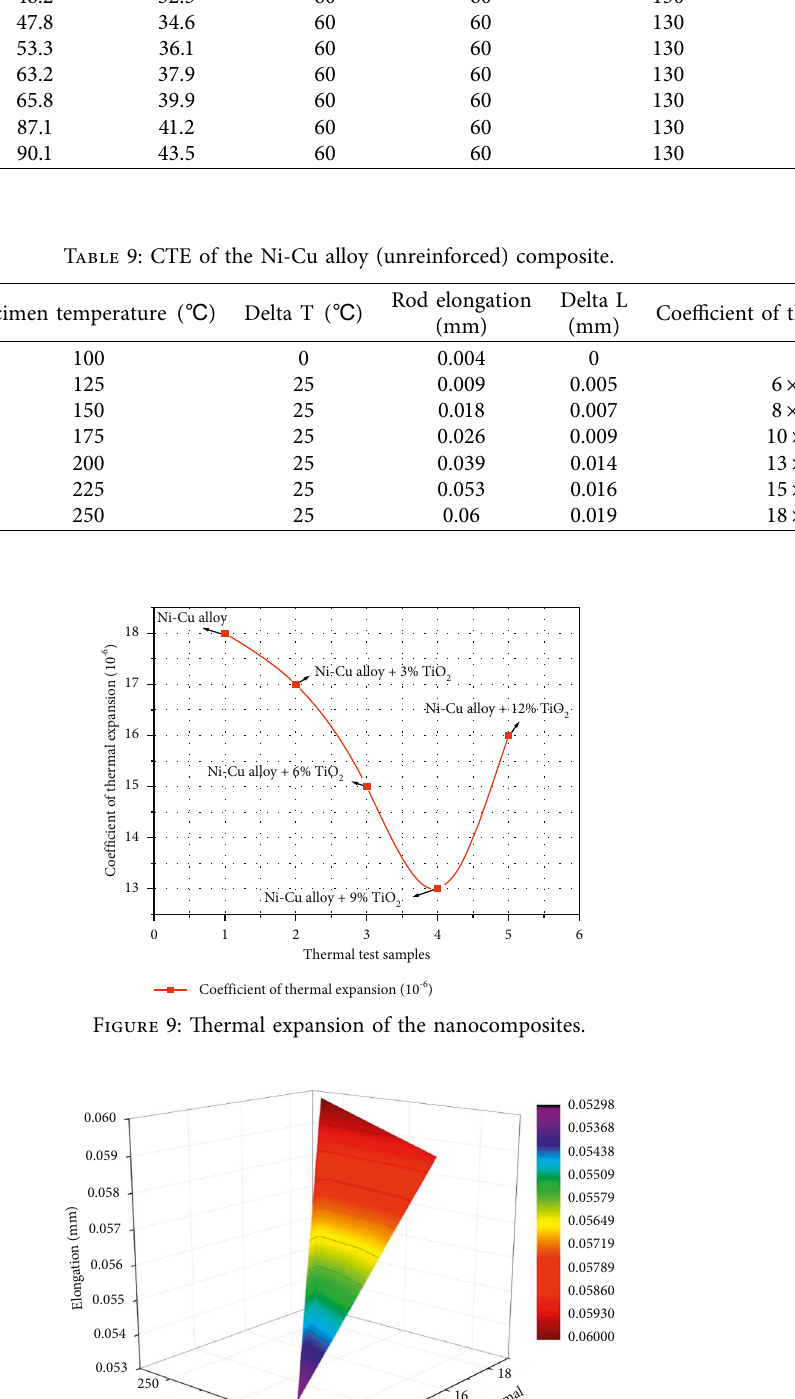
Table 8: Thermal conductivity (W/m ℃ ) of Ni-Cu+12% TiO